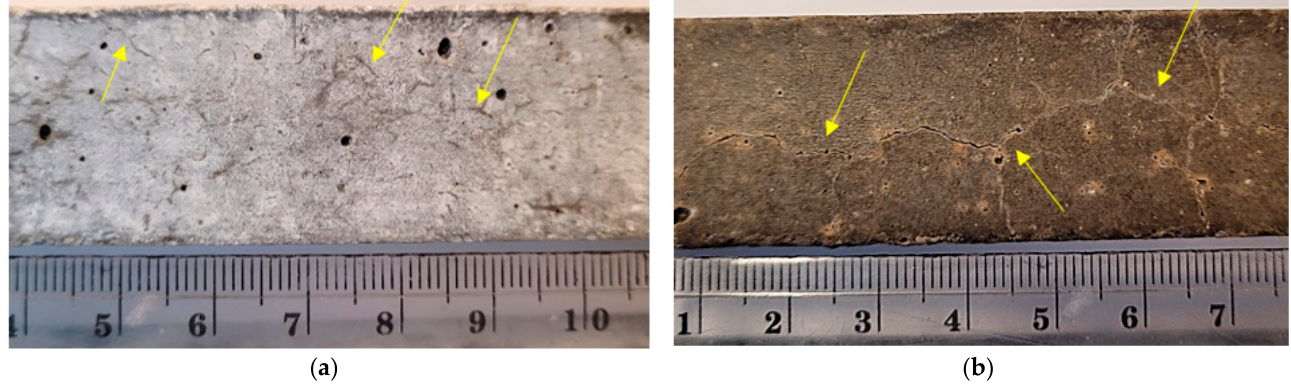
Figure 3. Cracks on the surface of mortar bars with quartzite Q aggregate immersed in ( a ) 1 M NaOH, ( b ) 50% HCOOK.